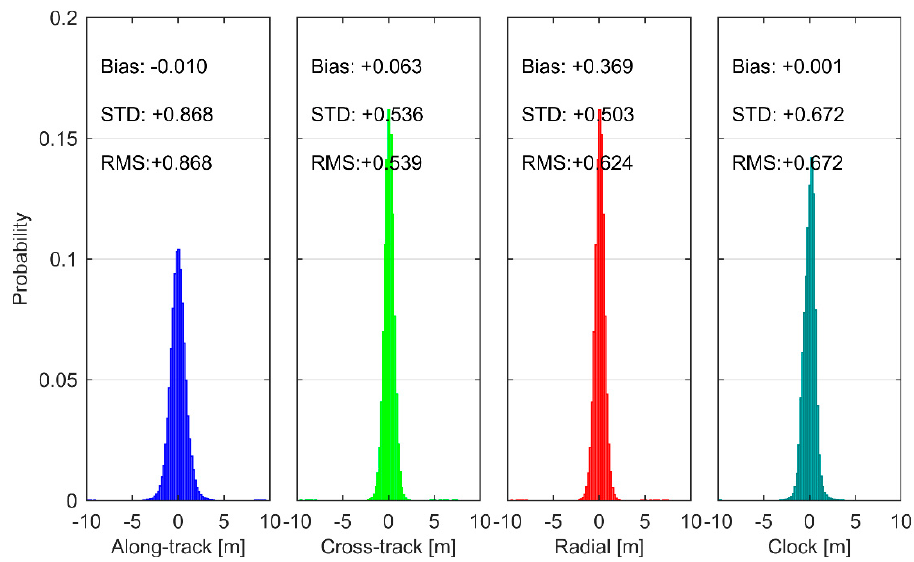
Figure 10. The distribution of SBAS-derived orbit and clock errors for SDCM PRN 125.